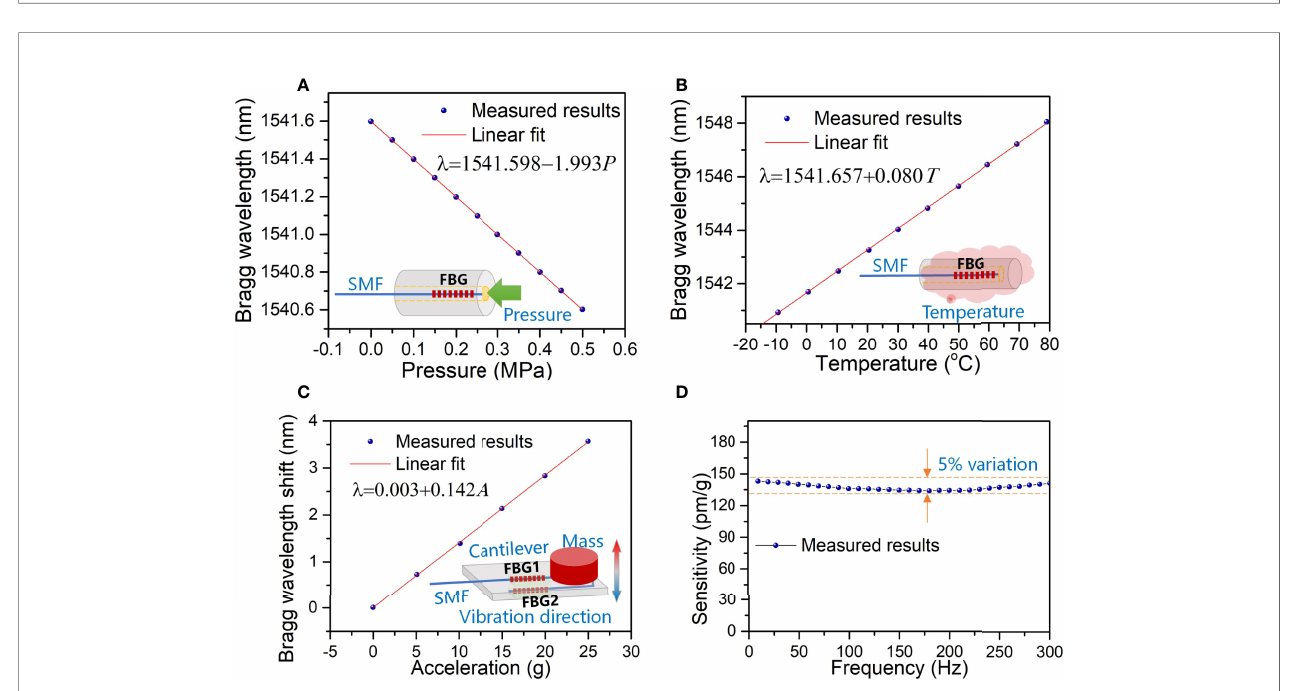
FIGURE 5 | Experimentally measured responses of the pressure, temperature, and vibration sensors, where (A) and (B) are the Bragg wavelength as a function of pressure and temperature change, C shows the wavelength shift with respect to the applied acceleration of the vibration, and (D) plots the frequency response of the vibration sensor.